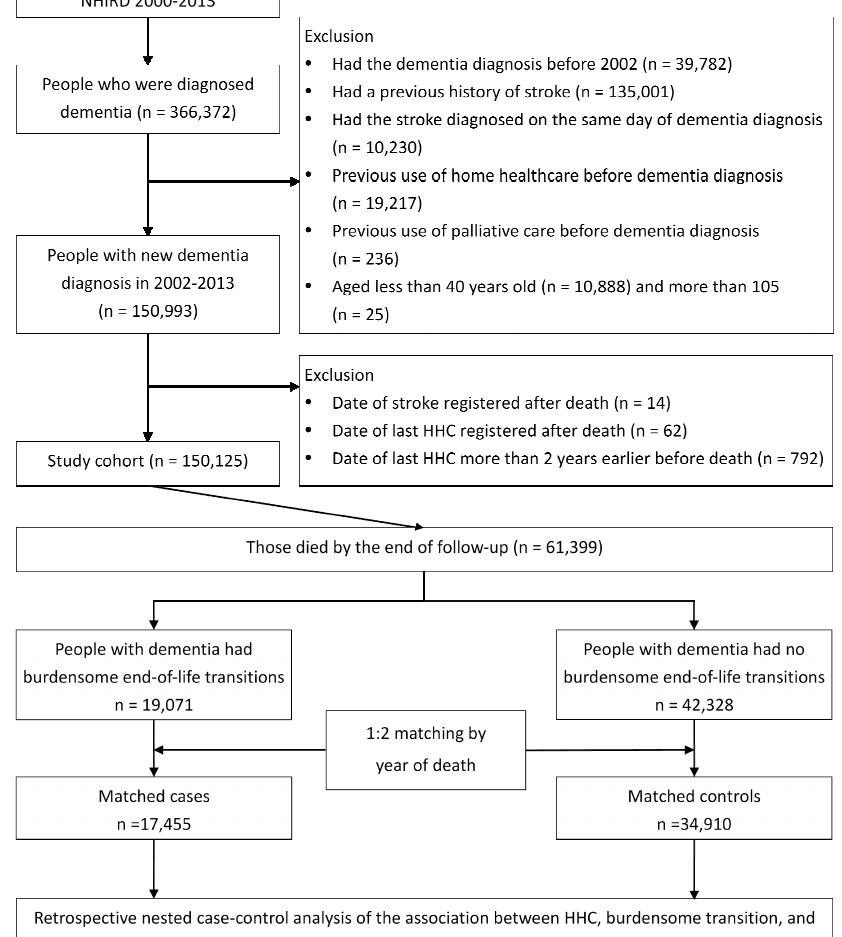
Figure 1. Schematic illustration of the study cohort and patient selection criteria. HHC = home healthcare and NHIRD = National Health Insurance Research Database.